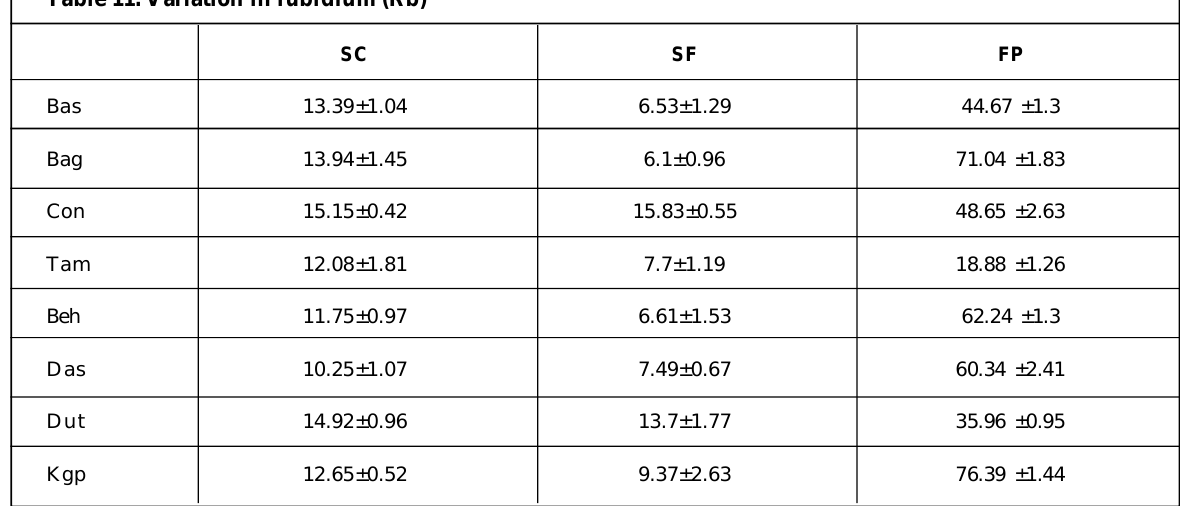
Table 11: Variation in rubidium (Rb)